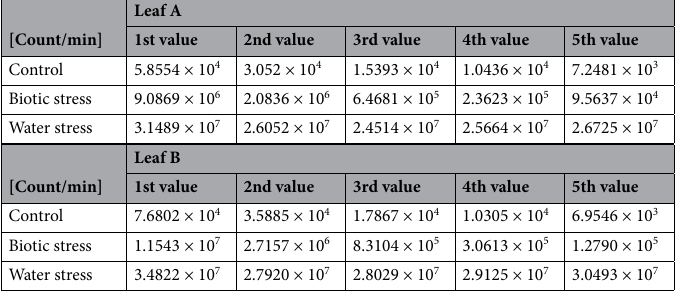
Table 1. Expected values of biophoton emission intensity on Leaf A and Leaf B, in different experimental groups (Control, Biotic stress, Water stress) in each time step.